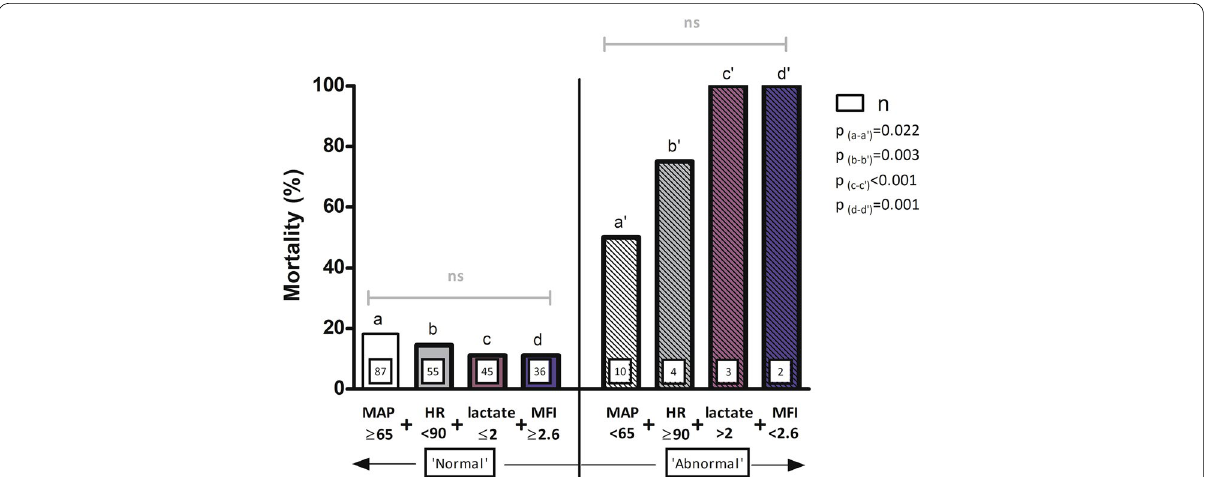
Fig. 2 Prognostic model with stepwise inclusion of consecutive hemodynamic variables: mean arterial pressure (MAP) in mmHg, heart rate (HR) in bpm, (arterial) lactate in mmol/L and Microvascular Flow Index (MFI) in AU